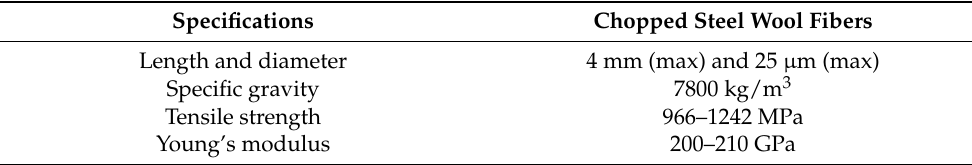
Table 3. The specifications of CSWFs